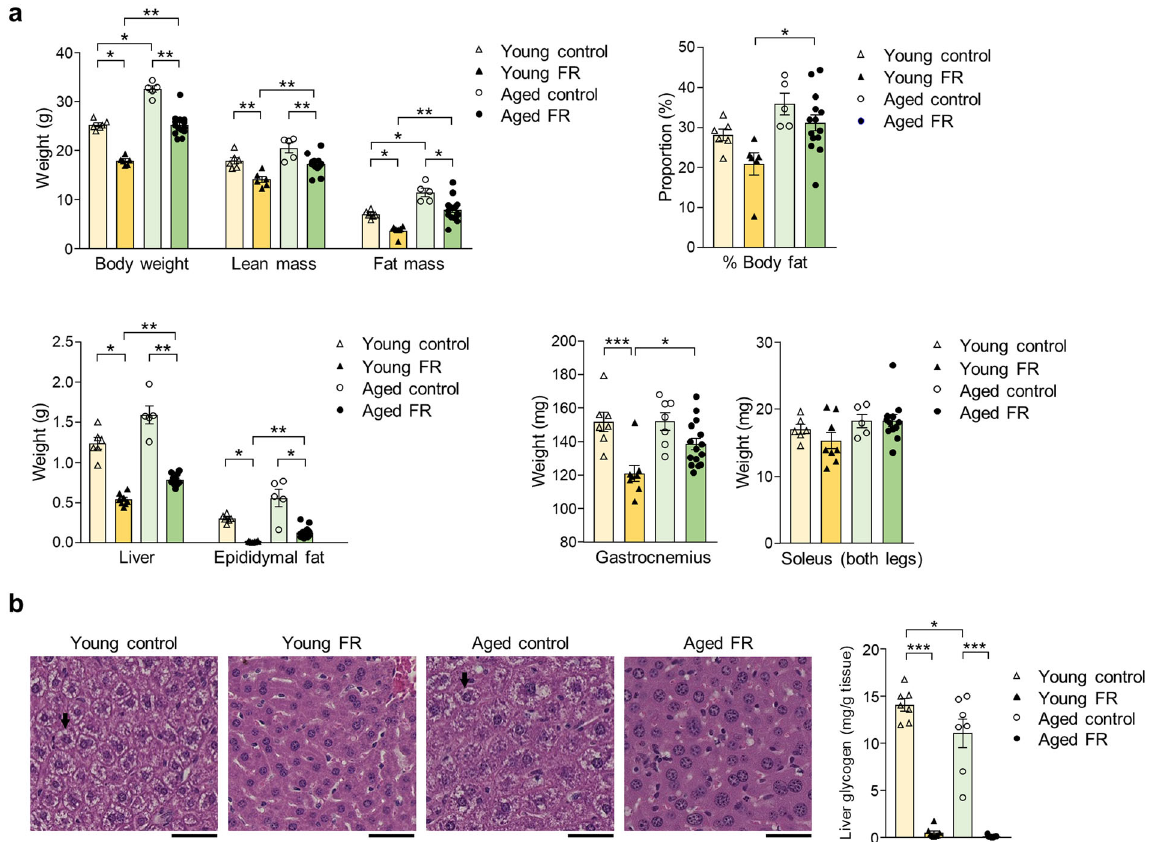
Fig. 2 Body composition and liver glycogen on day 5 of food restriction. a Body composition in young and aged mice subjected to 5-day food restriction (FR). * P < 0.05, ** P < 0.01 by Tukey − Kramer or Steel − Dwass test; young control ( n = 6), young FR ( n = 6), aged control ( n = 5), and aged FR ( n = 14). Tissue weights in young and aged mice subjected to 5-day FR. * P < 0.05, ** P < 0.01, *** P < 0.001 by Tukey − Kramer or Steel − Dwass test. Liver, epididymal fat, and soleus; young control ( n = 6), young FR ( n = 8), aged control ( n = 5), and aged FR ( n = 12). Gastrocnemius: young control ( n = 7), young FR ( n = 8), aged control ( n = 7), and aged FR ( n = 15). b The hematoxylin and eosin staining of liver sections for liver glycogen content. Arrows indicate sites of glycogen accumulation. Bar = 50 µm. * P < 0.05, *** P < 0.001 by Tukey ’ s test; young control ( n = 7), young FR ( n = 8), aged control ( n = 7), and aged FR ( n = 15). Data are presented as mean ±